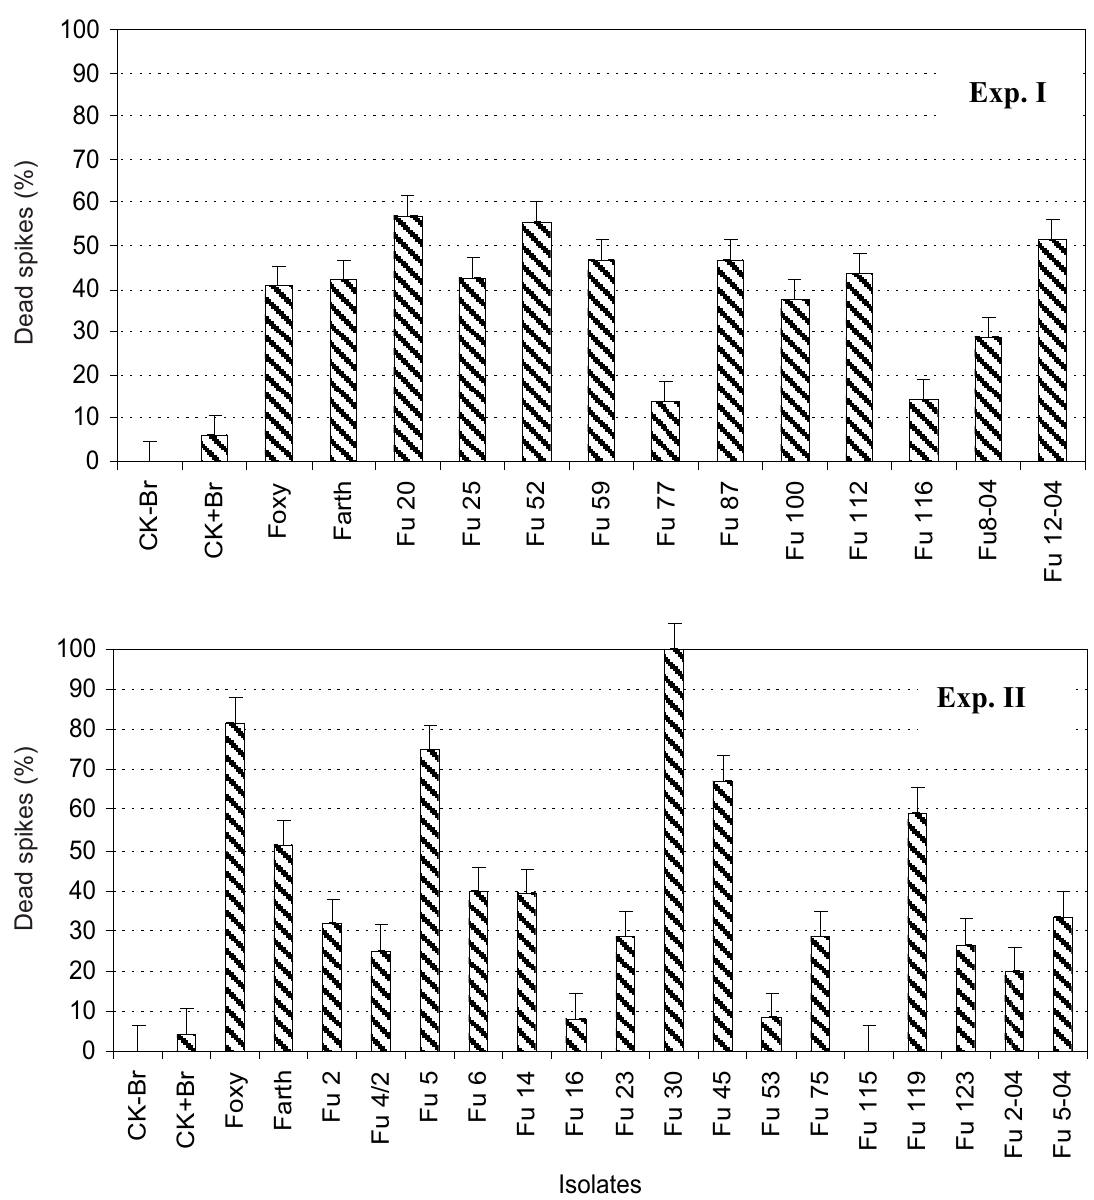
Fig. 1. Effect of Fusarium spp. isolates in pathogenicity tests on broomrape of tomato plants grown in pots.